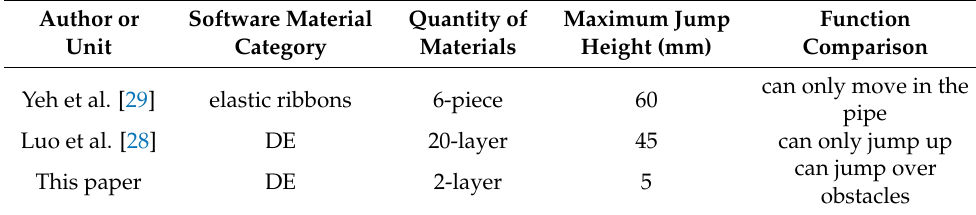
Table 2. Comparison of jumping function with other soft robots.